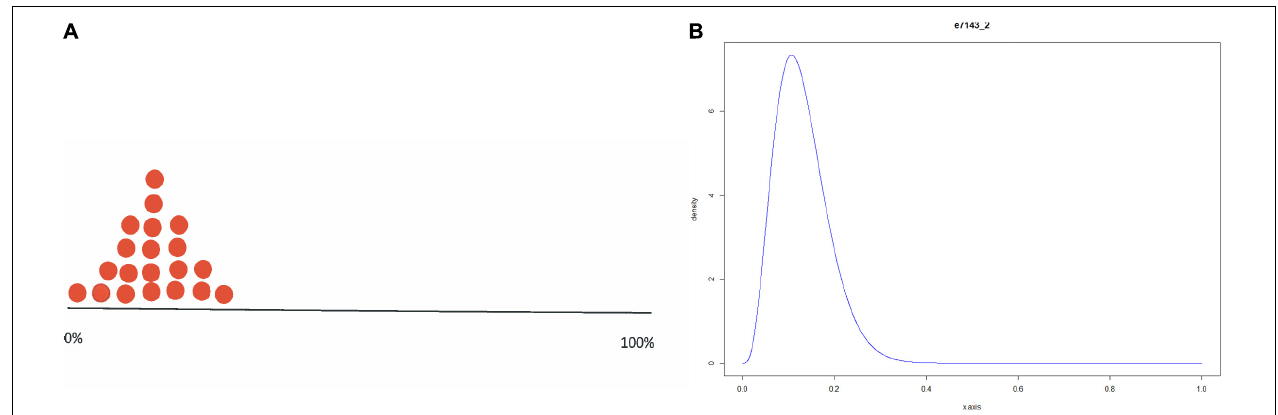
FIGURE 1 | Example of a stickered distribution using (A) the trial roulette method and (B) the probability distribution obtained with the SHELF software (Oakley and O’Hagan, 2010).